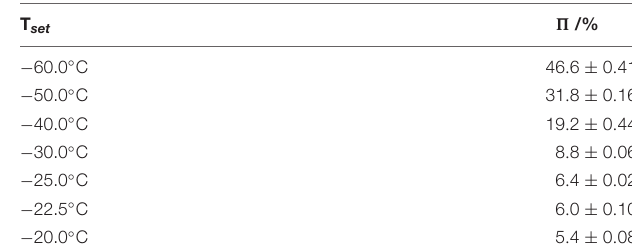
TABLE 1 | (cid:53) values of the freezing